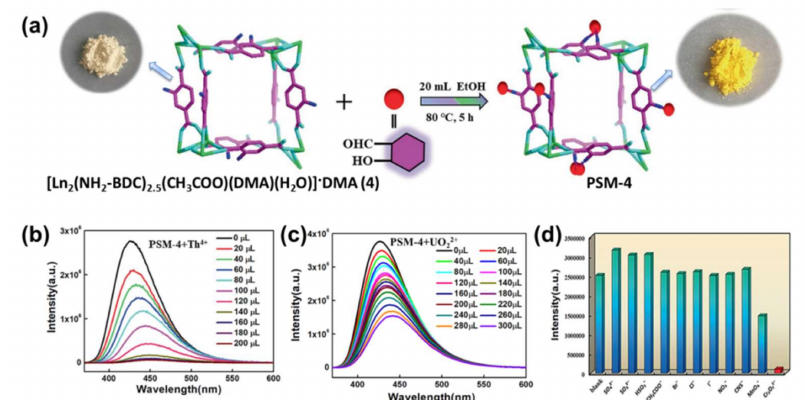
Figure 13. ( a ) Synthetic route of the post-synthesis modified PSM-4. ( b ) Fluorescence spectra of PSM-4 for the detection of Th 4+ . ( c ) Fluorescence spectra of PSM-4 for the detection of UO 2 2+ . ( d ) Fluorescence intensity of PSM-4 with the addition of different anions. Adapted from